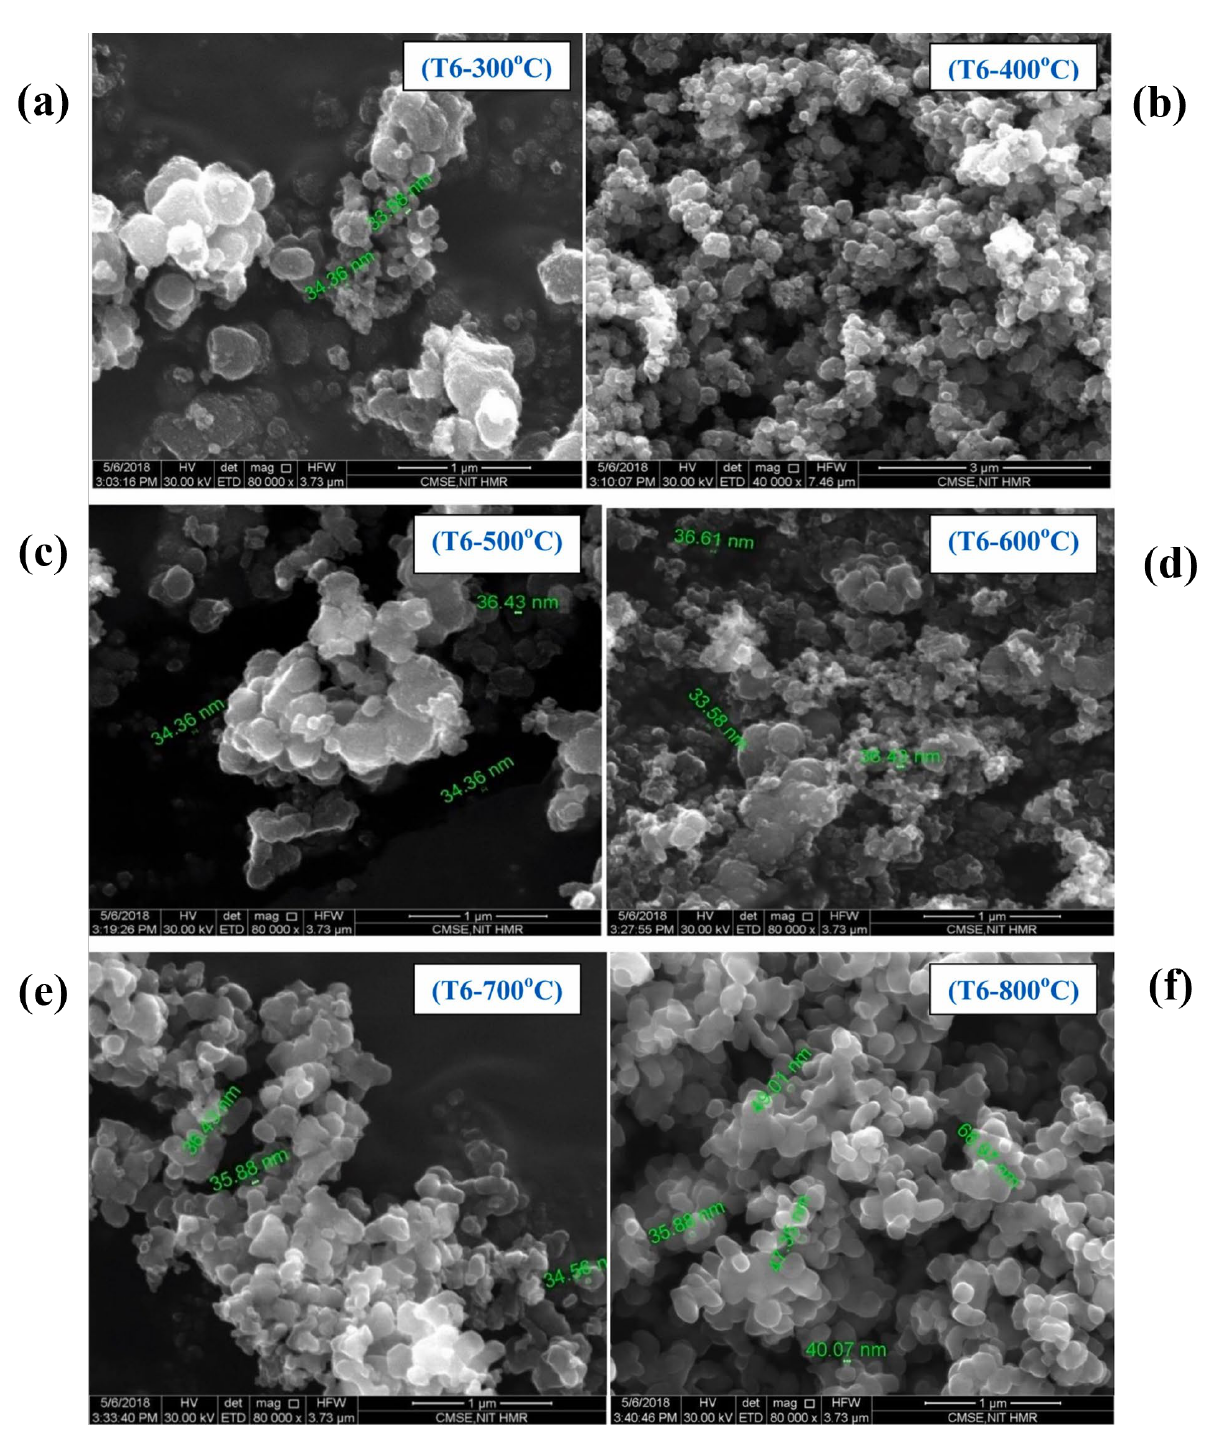
Figure 11. SEM images of TiO 2 prepared with varying calcination temperatures: ( a ) 300 °C, ( b ) 400 °C, ( c ) 500 °C , ( d ) 600 °C , ( e ) 700 °C, and ( f ) 800 °C at 6 mL of TTIP concentration. Reprinted from [32].